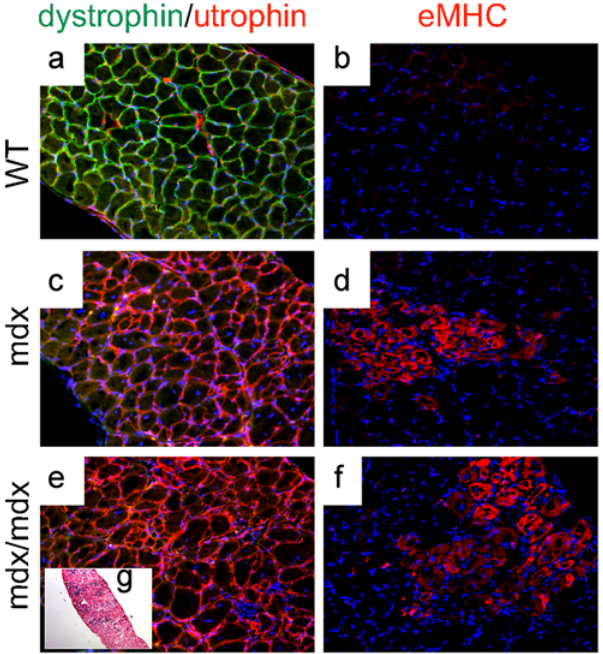
Figure 12. Mdx muscle receiving ESCs without dystrophin is dystrophic. a–f, diaphragms from WT (a, b), mdx (c, d) and R26 mdx/ mdx chimeric (e, f) mice were sectioned and stained for dystrophin (green) and utrophin (red) (a, c, e) and for eMHC (b, d, f). DAPI (blue) demarcates nuclei (200 6 ). g, Xgal/eosin staining of an adjacent section of (e, f) (100 6 ). Experiments were performed with pectoralis, diaphragm and quadriceps muscles of 4 animals (n=4) per group (WT, mdx and R26 mdx/mdx chimeras).